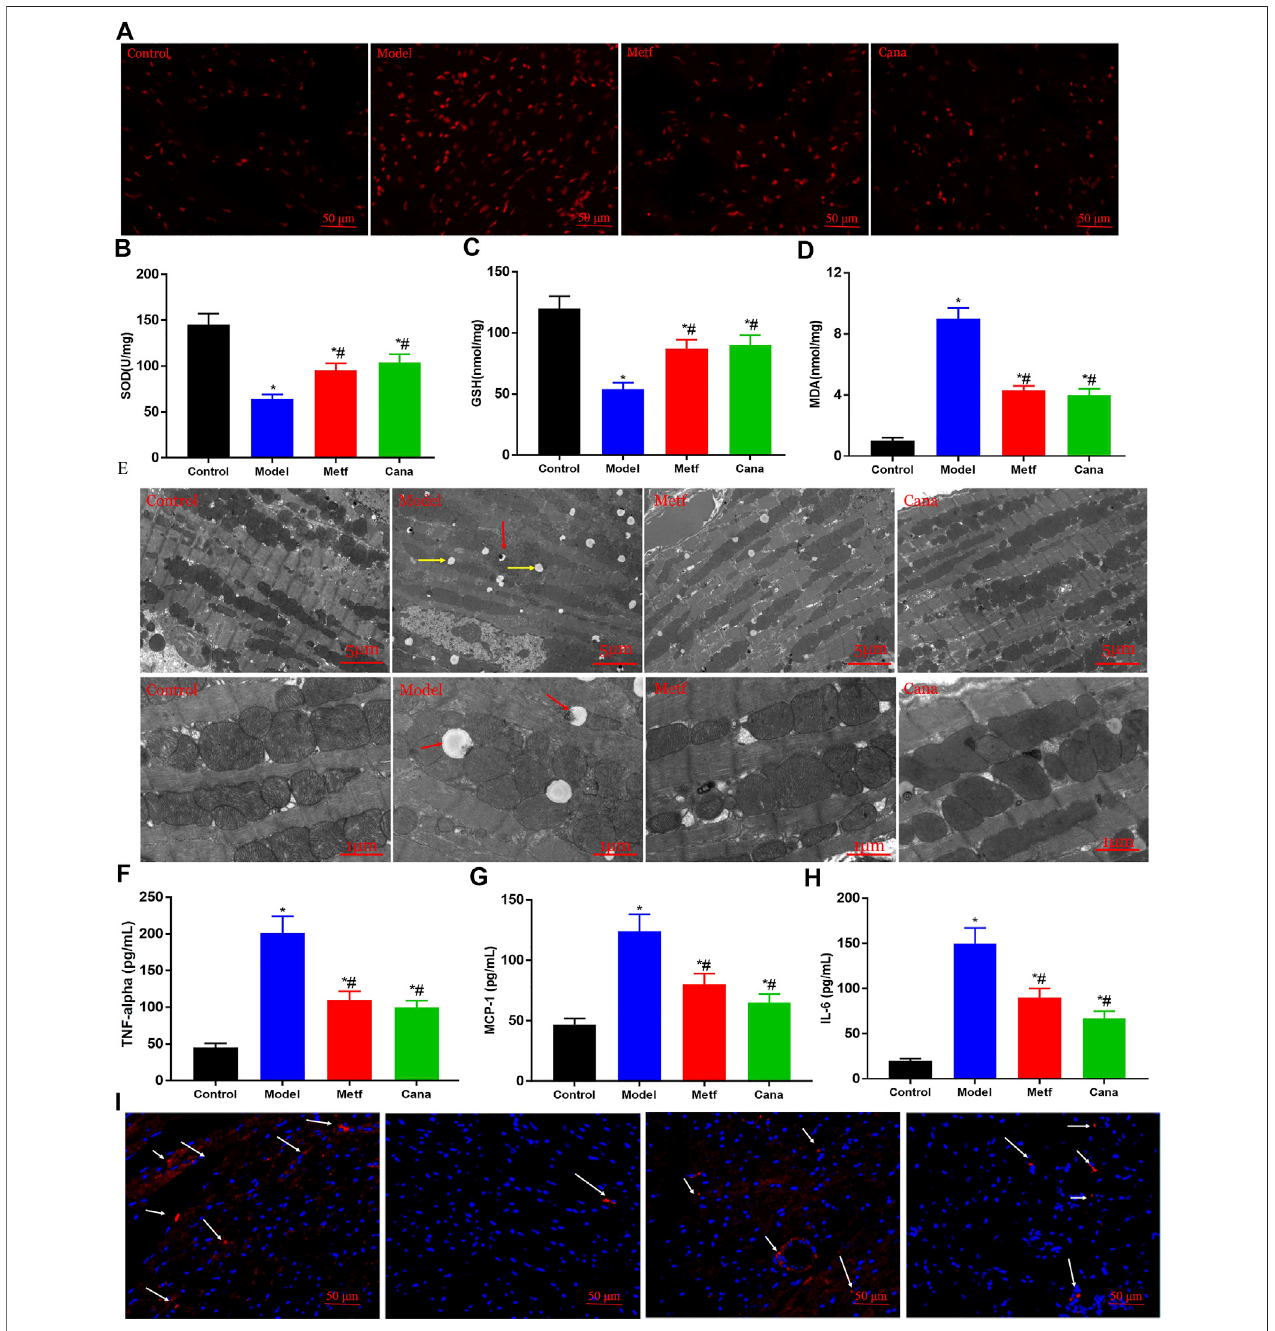
FIGURE 2 | Effects of Cana on alleviating oxidative stress and relieving in fl ammation. Reactive oxygen species (ROS) in cardiac tissues (A) . Superoxide dismutase (SOD) (B) , gluthathione (GSH) (C) , and malondialdehyde (MDA) (D) contents in cardiac tissues. The regulatory effect of Cana on cardiac mitochondria in myocardial tissues (E) . The scale bar is 5 and 1 μ m in the upper panel and bottom panel, respectively. Serum concentrations of tumor necrosis factor (TNF)-alpha (F) , monocyte chemotactic protein 1 (MCP-1) (G) ,and interleukin 6(IL-6) (H) .The immuno fl uorescence stainingofheme oxygenase1 (HO-1) in cardiac tissues, scalebar: 50 μ m (I) .Dataareexpressedasmean ± SEM.# p < 0.05,comparedwiththemodelgroup;* p < 0.05,comparedwiththecontrolgroup.Sixmiceineachgroupwererandomly selected for